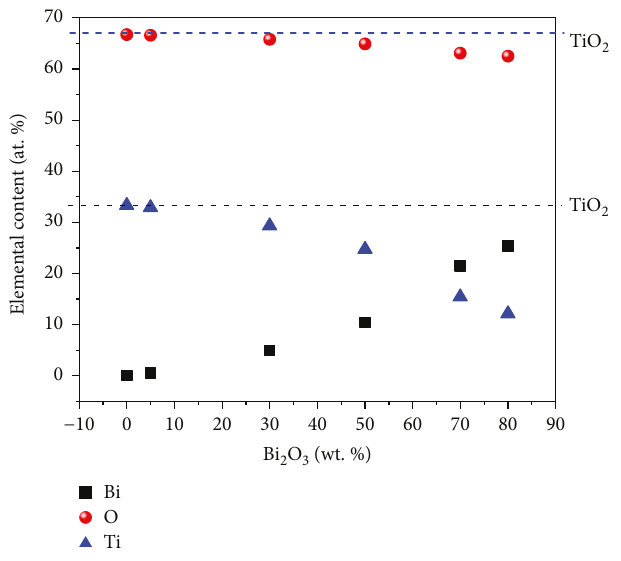
Figure 1: Atomic proportion of the thin fi lms as a function of the Bi O wt. %. 2 3